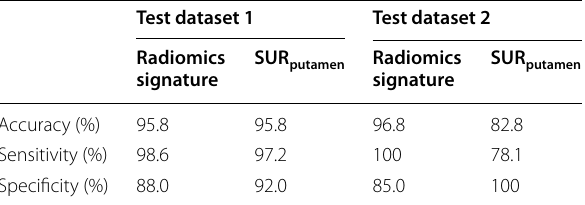
Table 4 Classification accuracy of radiomics signature and SUR for the test datasets putamen